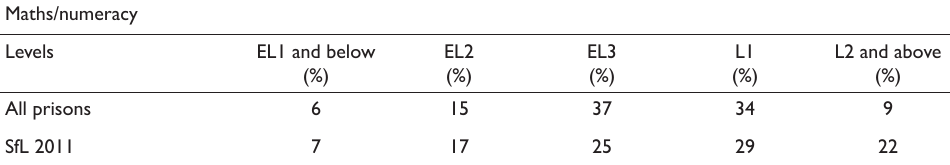
Table 3: Prisoners’numeracylevelscomparedwiththe2011SkillsforLife(SfL)survey